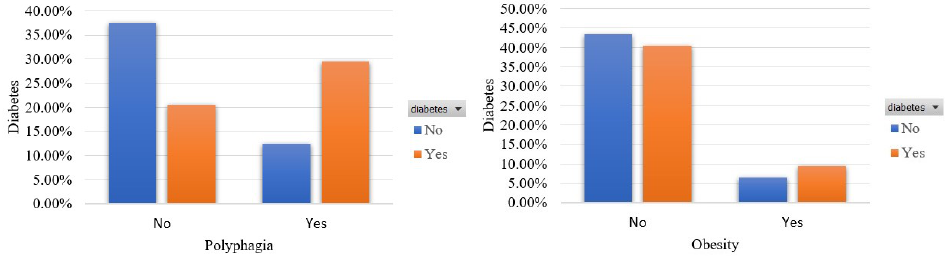
Figure 4. Participants’ distribution in terms of polyphagia and obesity in the balanced dataset.